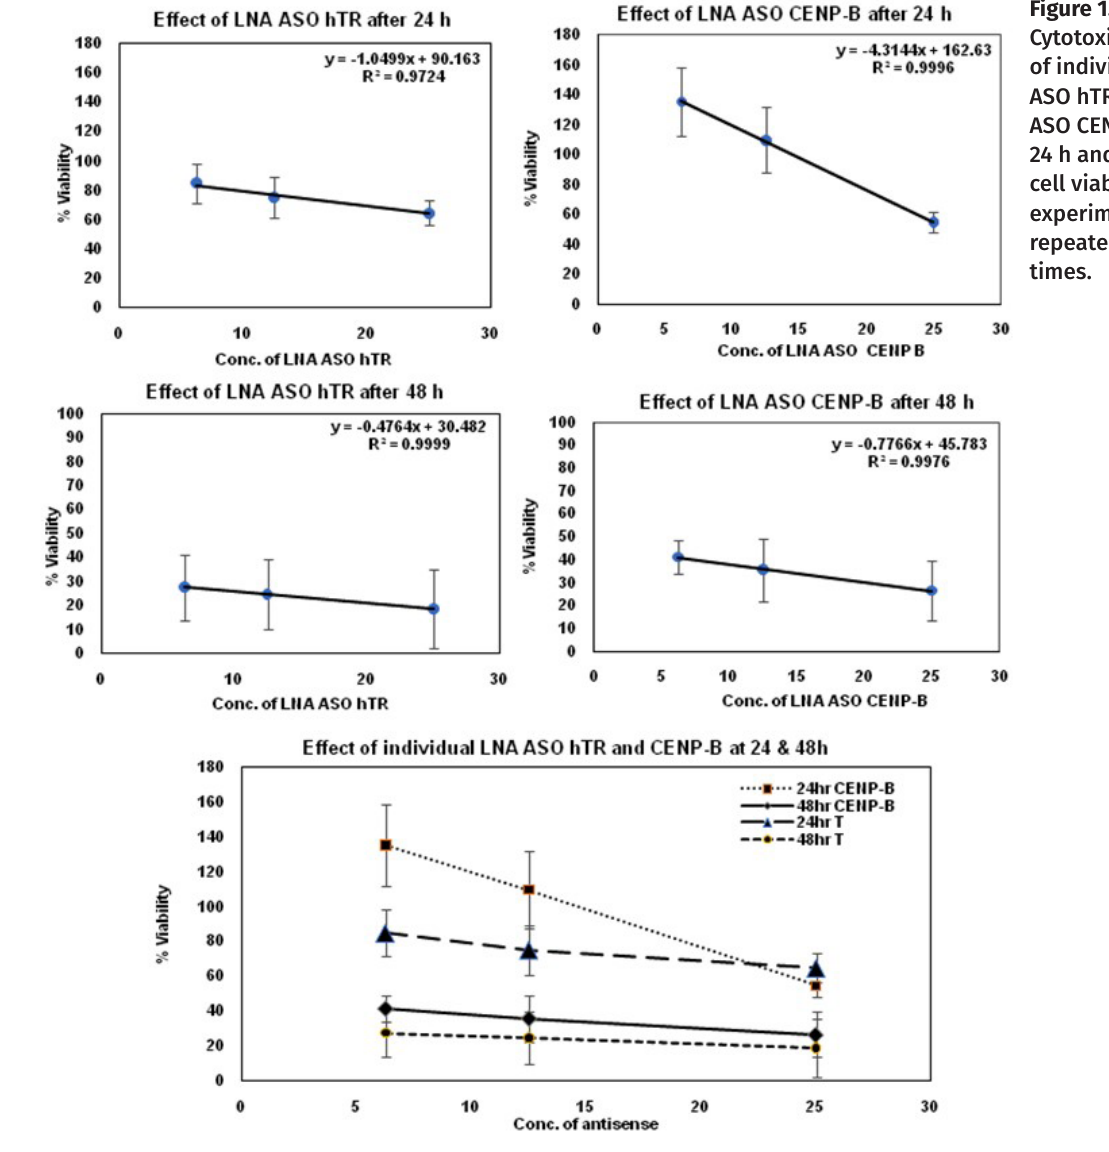
Figure 1. Cytotoxic effect of individual LNA ASO hTR and LNA ASO CENP-B after 24 h and 48 h on cell viability. The experiment was repeated three